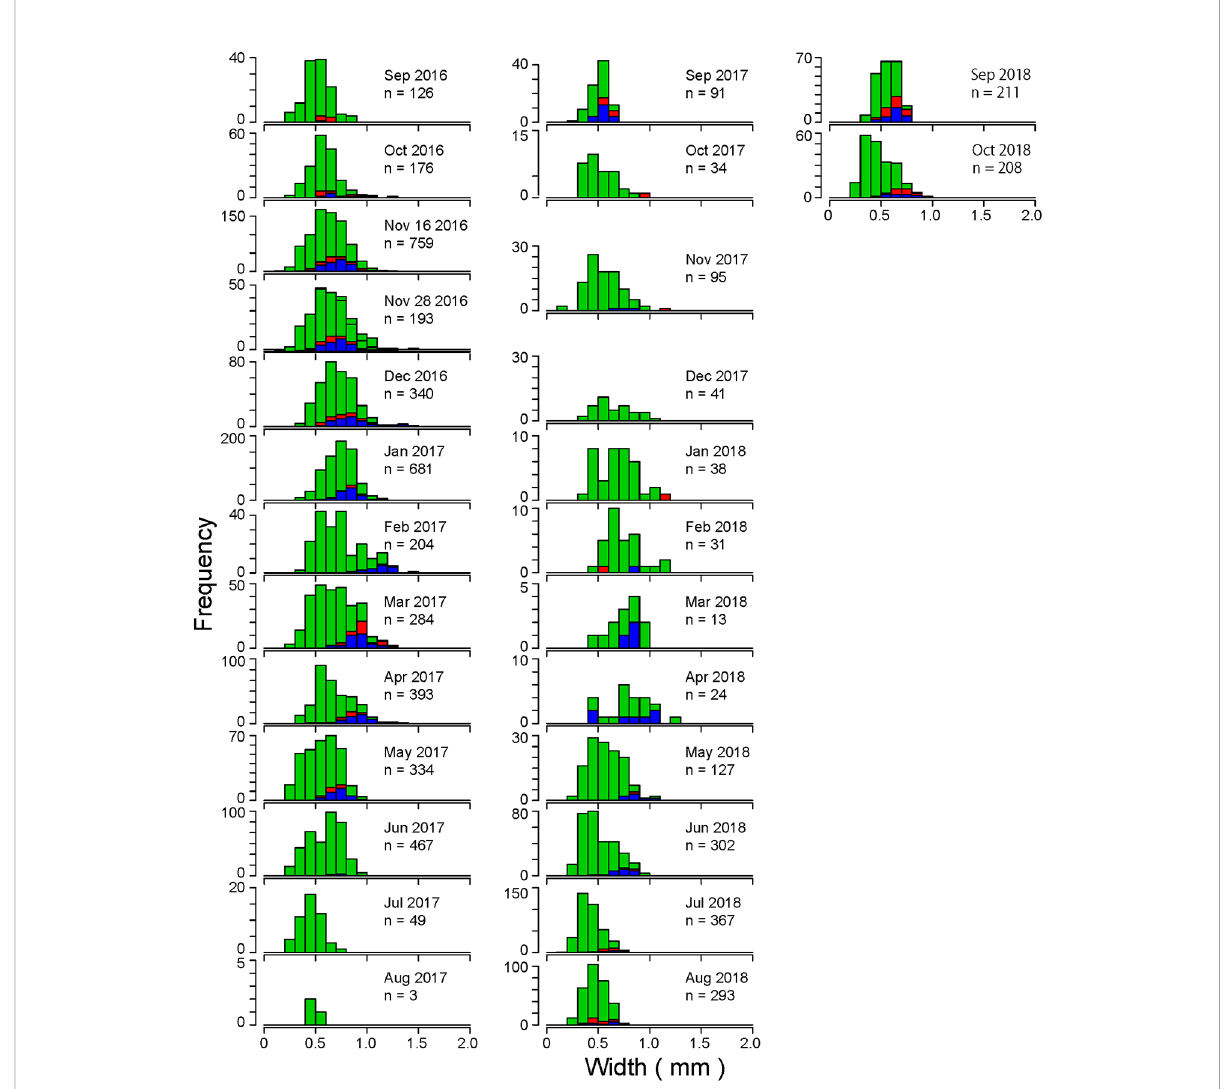
FIGURE 11 Size frequency distributions of the maximum width of the thoracic segment of total C. aff. teleta at the three stations in Gamo Lagoon from September 2016 to October 2018. Red: females, blue: males, green: immature